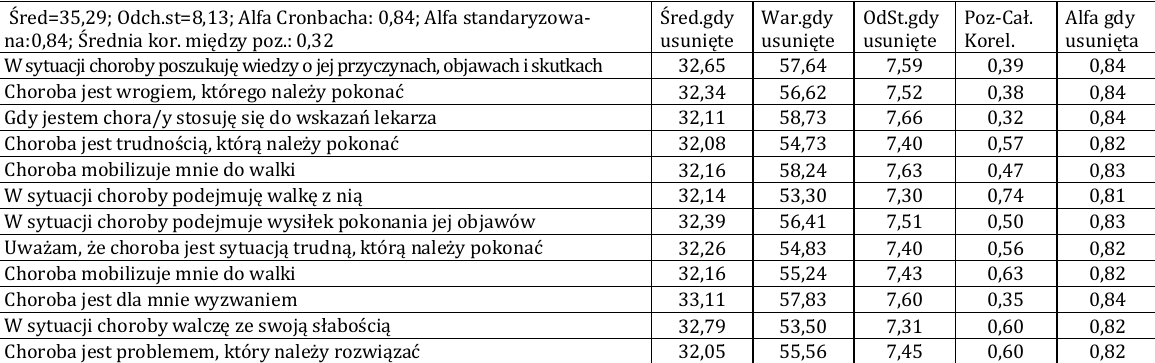
Tab. 4. Wyniki średnie, odchylenia standardowe oraz współczynniki rzetelności alfa Cronbacha dla całej skali oraz dla poszczególnych itemów tworzących skalę nazwaną – Choroba jako zadanie Śred=35,29; Odch.st=8,13; Alfa Cronbacha: 0,84; Alfa standaryzowa- na:0,84; Średnia kor. między poz.: 0,32